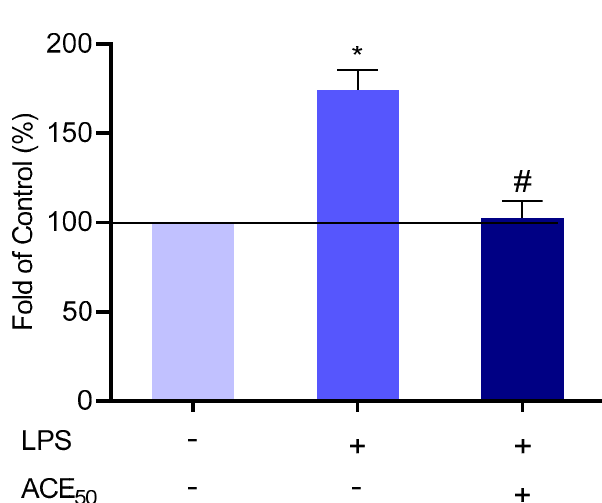
Figure 8. The level of tPA increased significantly compared to the control after LPS-treatment indicated by *. # indicates the significant changes in tPA in LPS-induced inflammation and ACE 50 treatment compared to the level of tPA in LPS-induced inflammation without ACE 50 . Results are expressed in the percentage of the control (100% is represented by the solid lines). Data are expressed as the mean ± SEM of four individual experiments. ACE 50 , 50 µ g / mL anthocyanin extract.